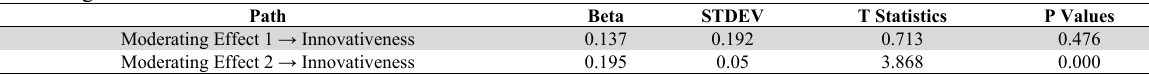
Moderating Effect